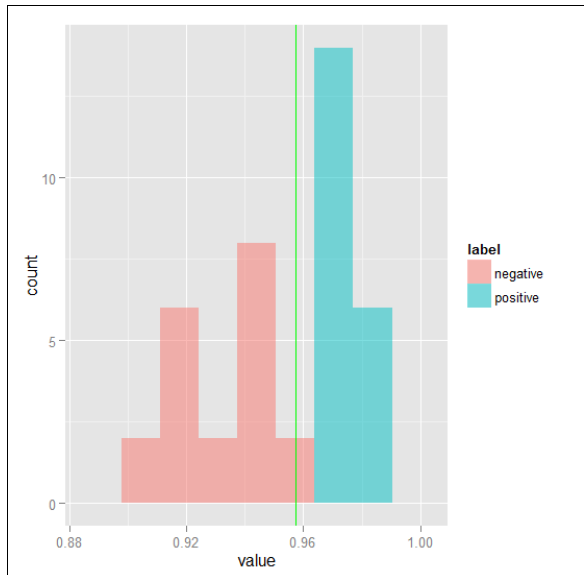
Figure 1. The separation with the green line (J statistic) between positive and negative features for the 128 scale